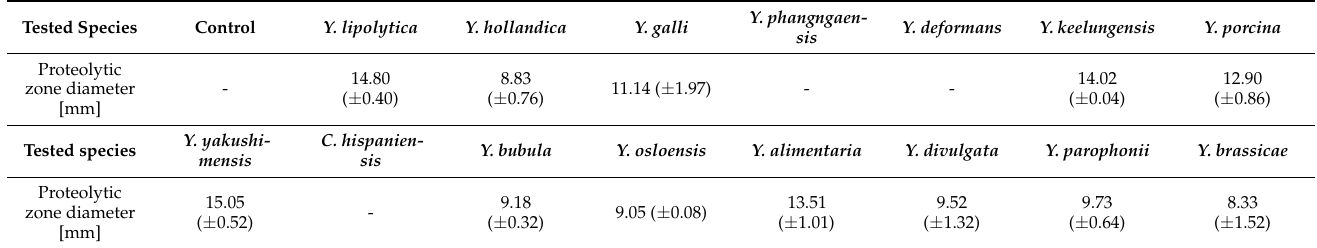
Table 3. Proteolysis zone diameter of Yarrowia clade species growing on skimmed milk agar plates. The results are presented as mean values ± SD. n =